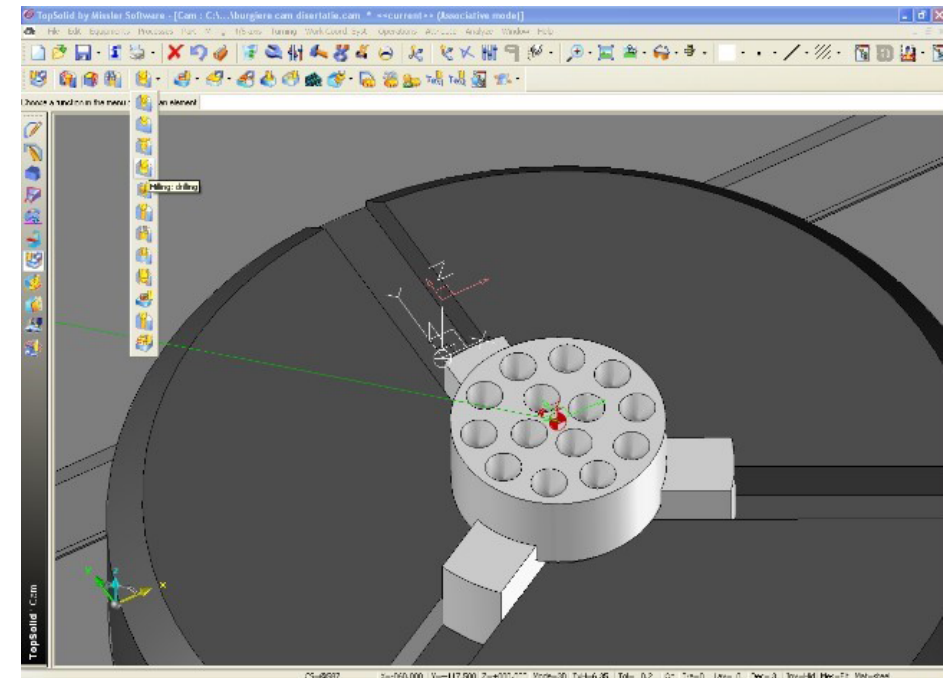
Figure 19. Manufacturing simulation in TopSolid